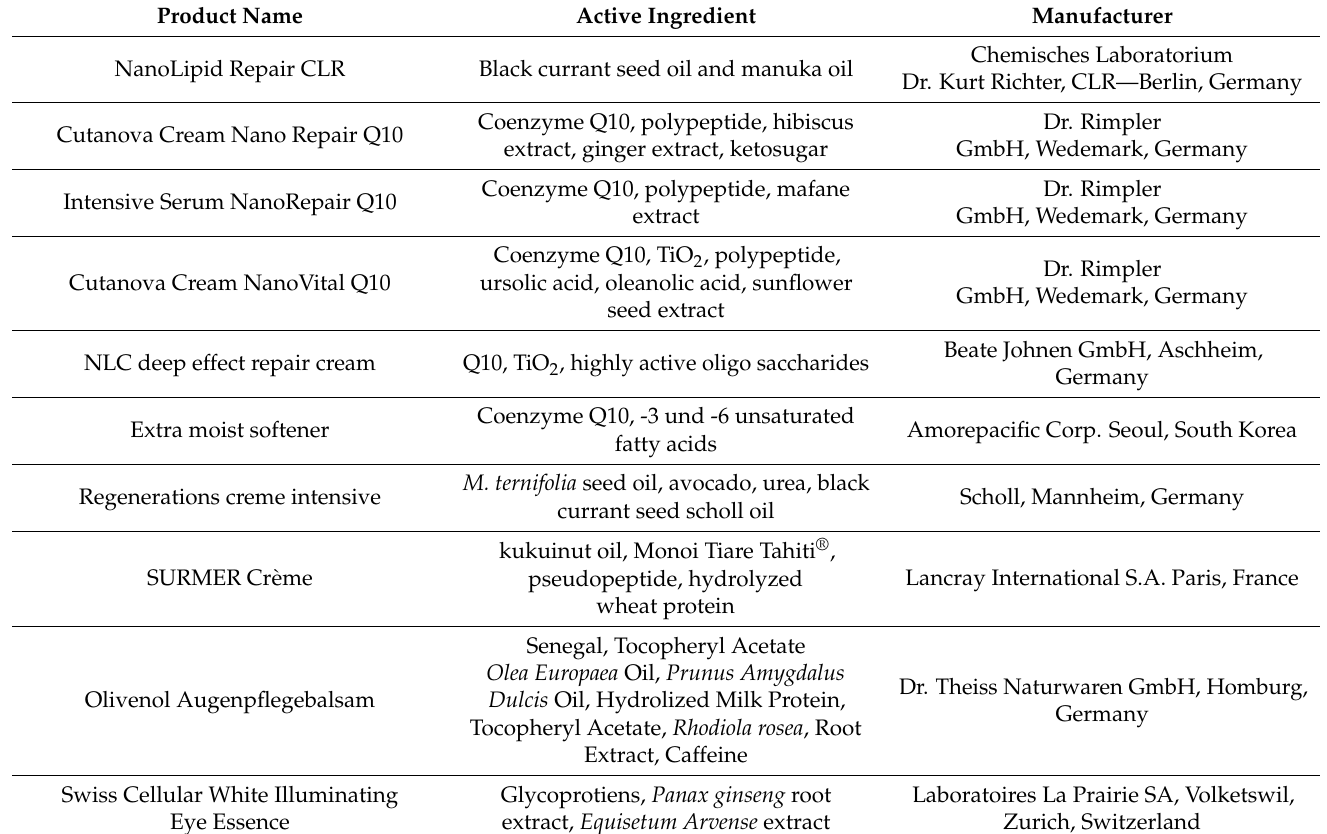
Table 1. Lipid nanoparticles-based cosmetics products in the market.